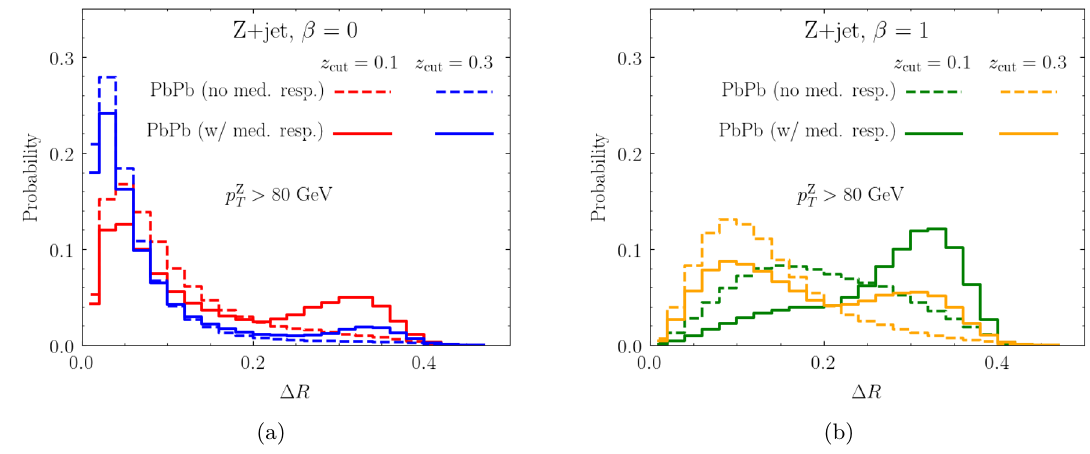
Figure 8. ∆ R distributions with and without medium response for z cut = 0 . 1 , 0 . 3 , β = 0 (a) and z cut = 0 . 1 , 0 . 3 , β = 1 (b), for jets recoiling against a Z boson with p T above 80 GeV (namely, jets selected as in the orange curves of figure 5b). All curves are for quenched jets as in PbPb collisions. Dashed curves indicate in-medium jets where hadrons originating from the wake in the medium have been artificially excluded, whereas solid curves indicate those where particles from the response of the medium are